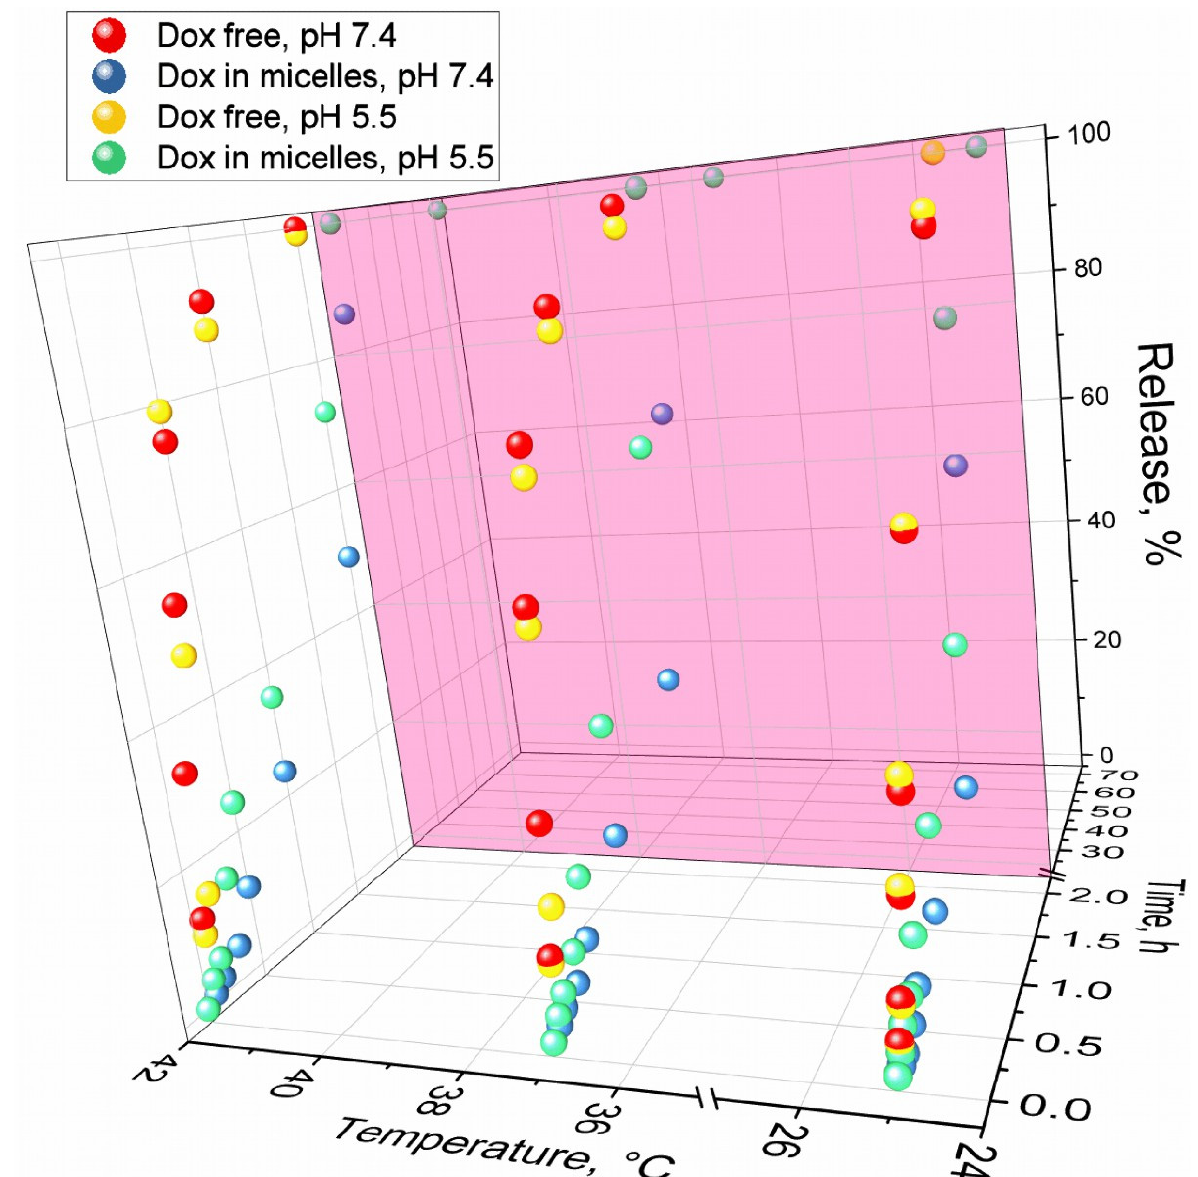
Figure 6. Release kinetics curves of free Dox and micellar (Chit5-MUA-20) forms of Dox complexes (1 mg/mL, 50% Dox w / w ). Dialysis membrane (12–14 kDa cut-off) into an external solution (1:10 by volumes). PBS (pH = 7.4, 0.01 M), sodium acetate buffer (pH = 5.5, 0.01 M). Dox is detected by absorption at 488 nm. T = 25, 37, and 42 °C.